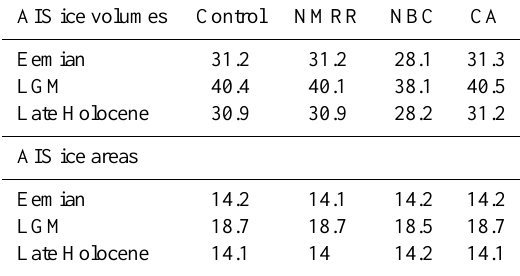
Table 2. Final AIS ice volumes ( / 10 6 km 3 ) and areas ( / 10 6 km 2 ) for all equilibrium experiments. NMRR=no melting/refreezing; NBC=no bias correction; CA=constant albedo.